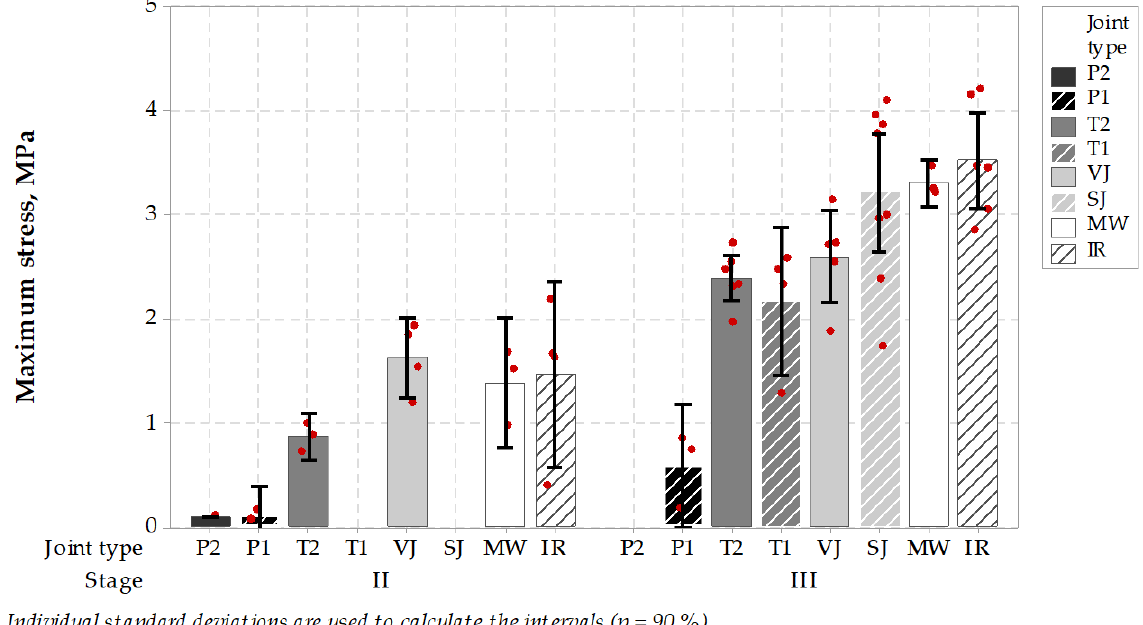
Materials 2021 , 14 , x FOR PEER REVIEW